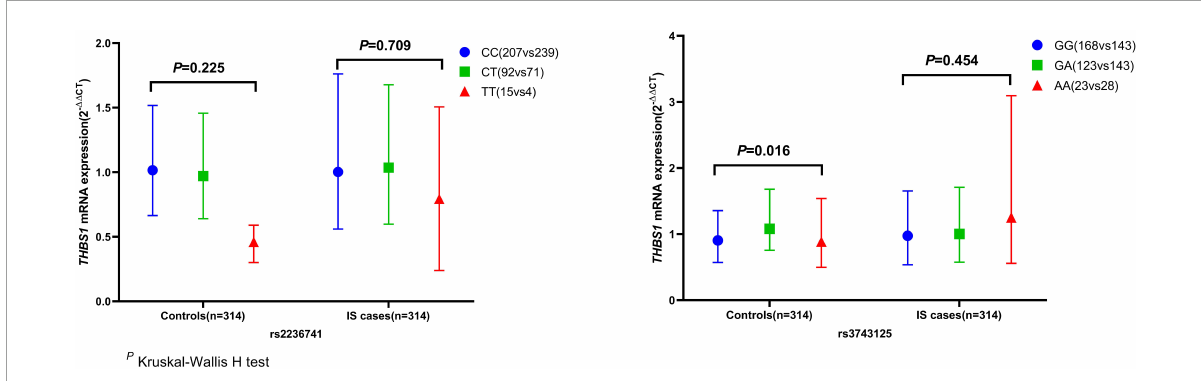
FIGURE2 THBS1 gene mRNA expression (2 – (cid:49)(cid:49) CT ) among different genotypes of rs2236741 and rs3743125. The THBS1 mRNA expression levels significantly differed across rs3743125 GG, GA, and AA carriers in the control group (0.91 vs. 1.08 vs. 0.89, P = 0.016) but were not significantly different in IS group (0.97 vs. 1.00 vs. 1.25, P = 0.454). Besides, there were no significant differences across rs2236741 CC, CT, and TT carriers in the control group (1.02 vs. 0.97 vs. 0.54, P = 0.225) or in the IS cases (1.00 vs. 1.04 vs. 0.79, P =